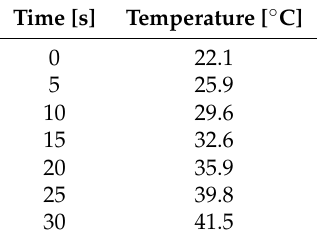
Time [s] Temperature [ ◦ C]